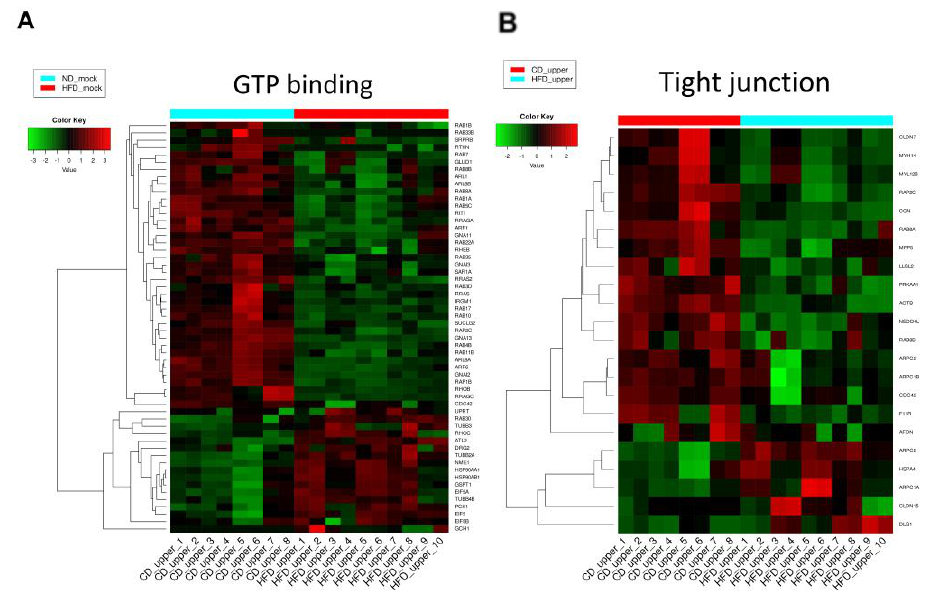
Figure 6. Heatmaps of DEPs include “GTP binding” (GO: 0005525, ( A )) and “Tight Junction” (mmu Figure 6 . Heatmaps of DEPs include “GTP binding” (GO: 0005525, ( A ) ) and “Tight Junction” (mmu 04530, ( B )). 04530, ( B )).